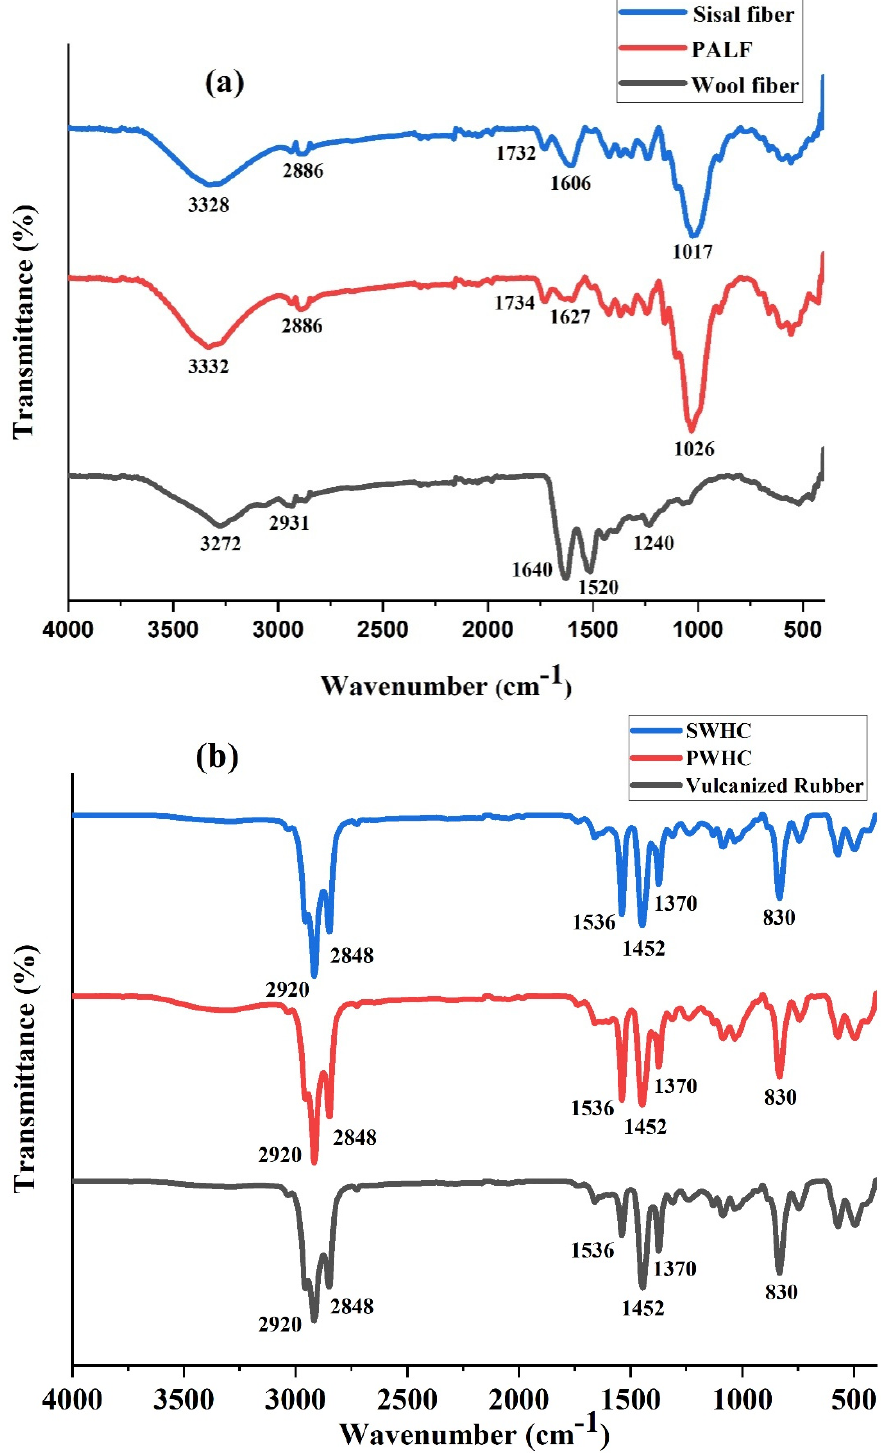
Figure 3. FTIR spectrum of ( a ) sisal fibre, PALF and wool fibre ( b ) vulcanized rubber, PWHC and SWHC.